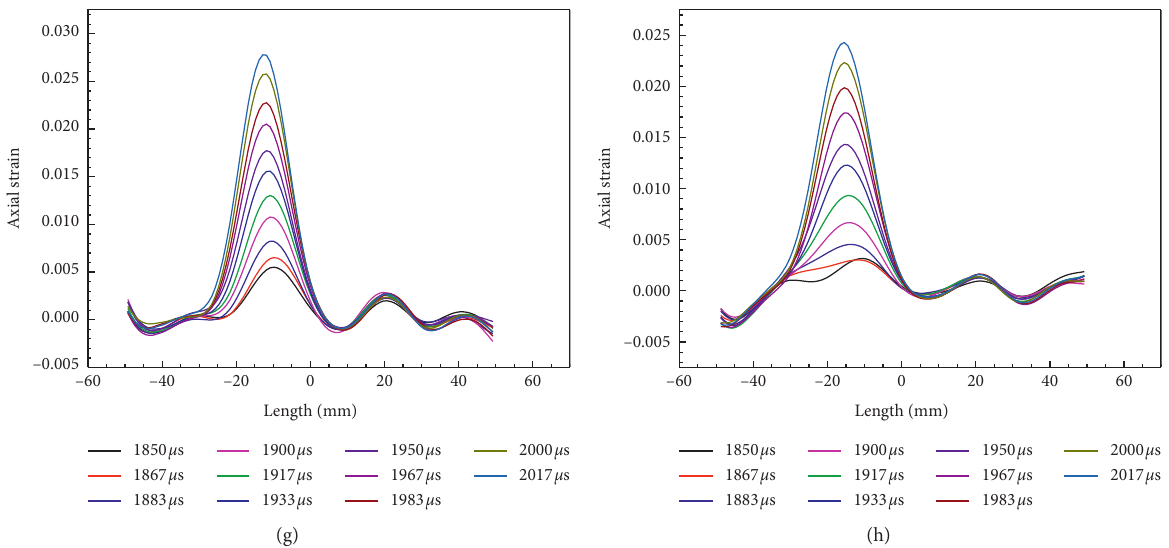
Figure 10: Axial strain on the line of interest at a different time for test 3. (a) LOI 1 (abnormal data points are eliminated), (b) LOI 2, (c) LOI 3, (d) LOI 4, (e) LOI 5, (f) LOI 6, (g) LOI 7, and (h) LOI